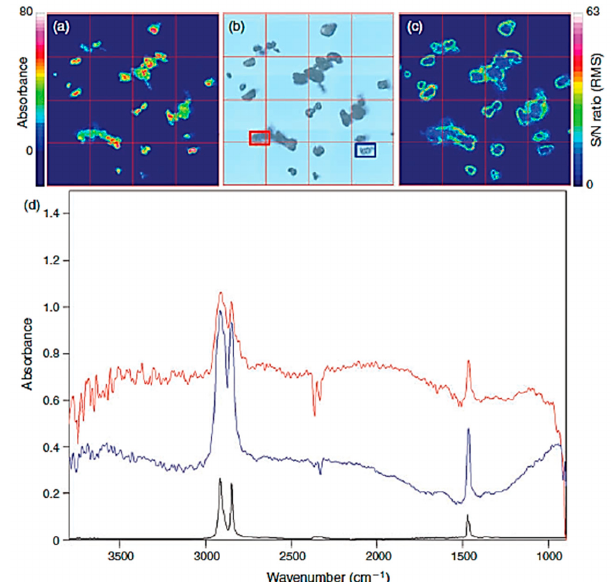
Figure 8. Results of transmittance focal plane array (FPA) detector-based micro-Fourier-transform infrared imaging of polyethylene (PE) powder on a blank CaF2 crystal. ( a ) Imaging of the wavenumber 2980–2780 cm − 1 . ( b ) Visual picture of the PE sample. ( c ) Signal-to-noise (S / N) ratio, e ff ective noise calculated with the root mean squares (RMS) method, in the wavenumber range 2980-2780 cm − 1 . ( d ) Spectra acquired at a point of intermediate intensity (red spectrum, point marked by red square in ( b )) and at a point of high intensity (blue spectrum, point marked by blue square in ( b )), PE reference spectrum in black. The colour bars represent the intensity of the integrated band or S / N ratio. The edge length of a red outlined FPA field is 170 µ m [69]. (Republished with permission of CSIRO, from ref. [69]; permission conveyed through Copyright Clearance Center, Inc., Danvers, MA,